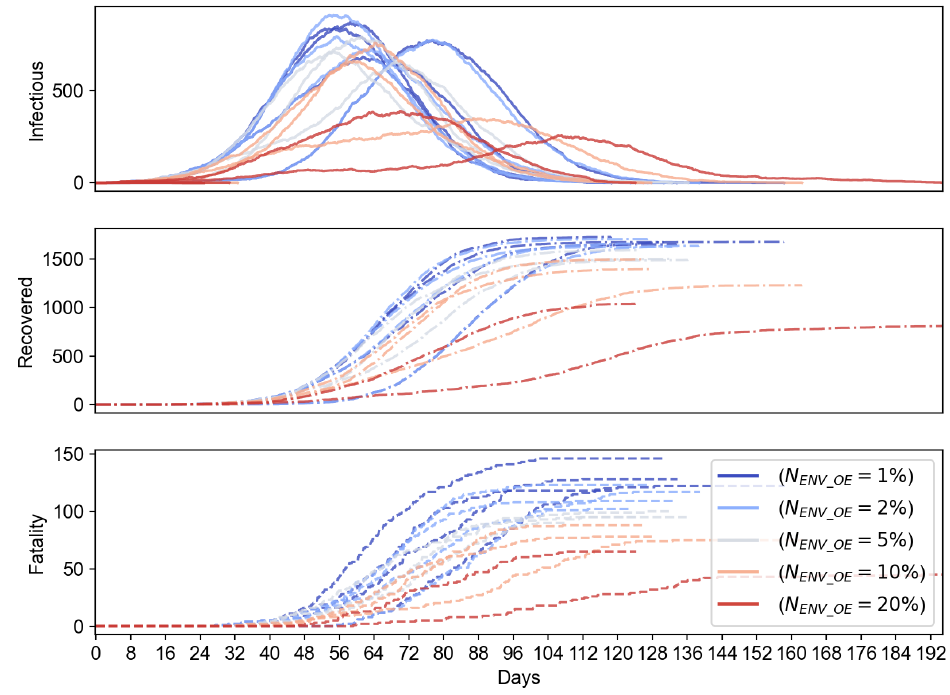
Figure 9. Epidemiological performance vs. the number of environment sensors ( N ENV _ OE ) ( s = 2.35 m/s, N OE = 200, T d =